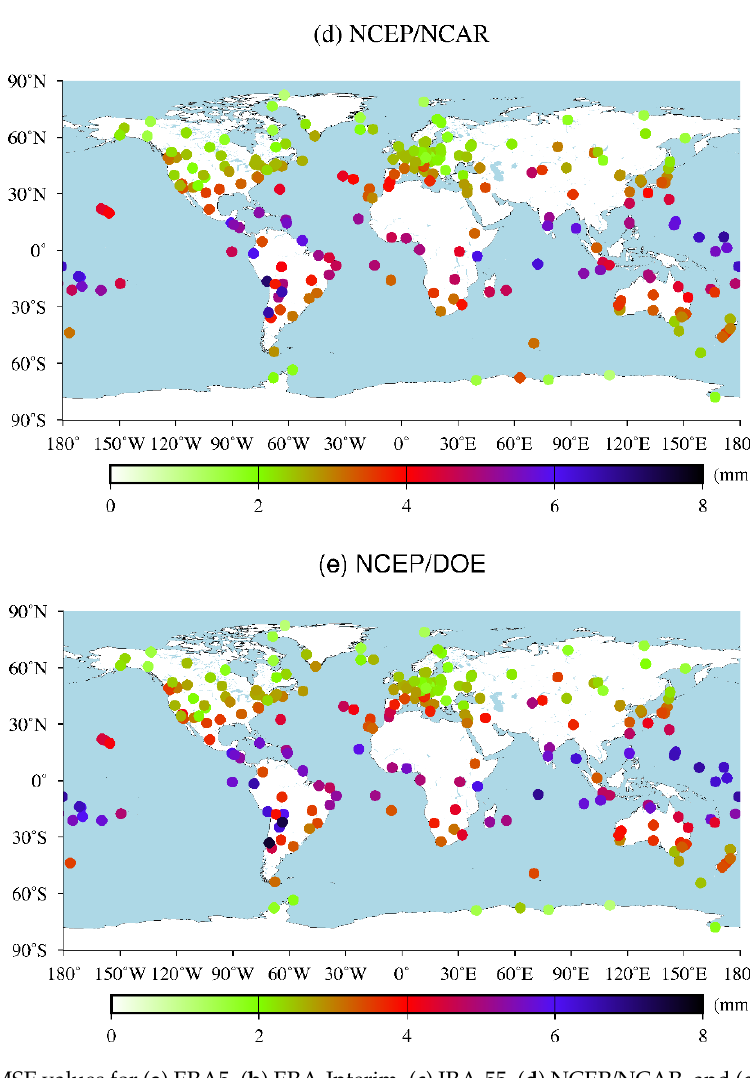
Figure 4. RMSE values for ( a ) ERA5, ( b ) ERA-Interim, ( c ) JRA-55, ( d ) NCEP / NCAR, and ( e ) NCEP / DOE reanalysis water vapor products relative to GNSS PWV around the world (source: own elaboration).